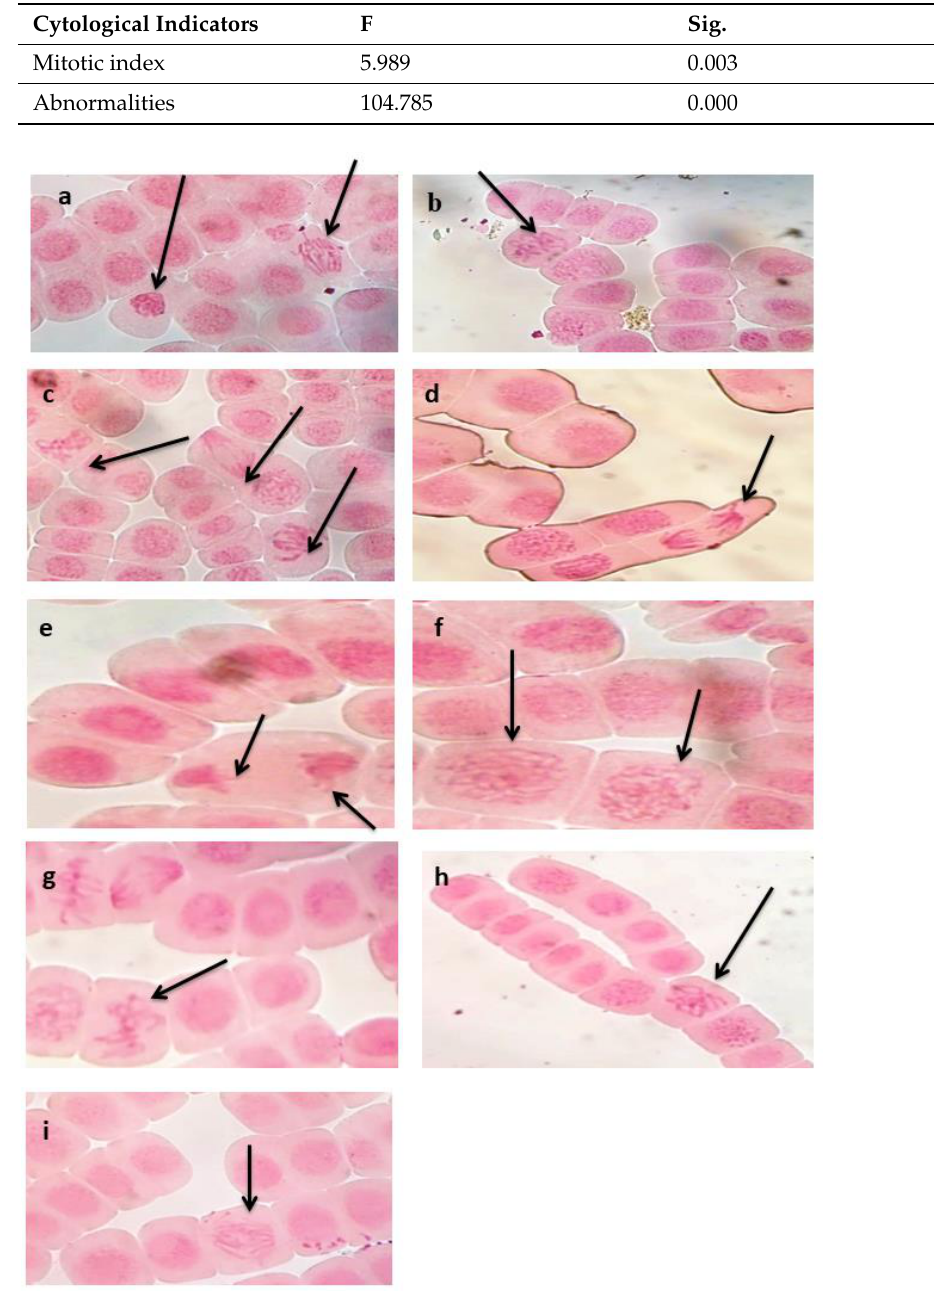
Figure 5. Types of abnormalities observed in V. faba root tips cells due to microplastic effect in soil and mitigation by biochar. ( a ) Stickiness prophase and anaphase with bridge and vagrant chromosome, ( b ) C–metaphase, ( c ) Disrupted metaphase, anaphase with fragment and C-metaphase, ( d ) Anaphase with laggard chromosome, ( e ) Telophase with laggard chromosome, ( f ) Scattered ball metaphase, ( g ) Pole-to-pole metaphase, ( h ) Star anaphase ( i ) Multipolar